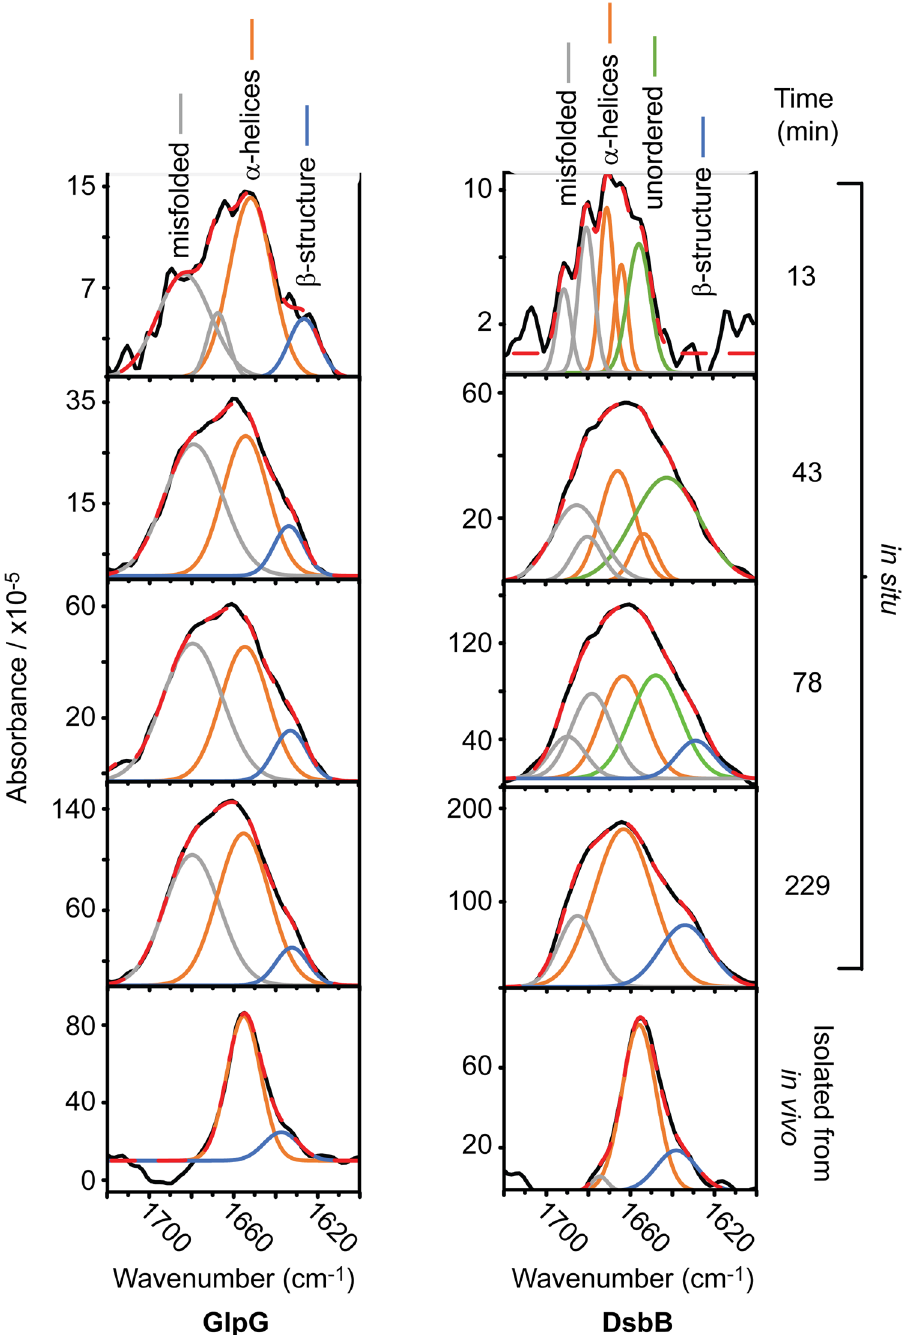
Figure 4. Secondary structure contributions over time during GlpG and DsbB cell-free synthesis. Raw SEIRAS spectra of the amide I band during GlpG (left) and DsbB (right) cell-free synthesis, insertion and folding into DMPC nanodiscs. A change in the proportion of each secondary structure type occurs as folding progresses. The black line is the experimental data and the dashed red line is the cumulative fit of the individual Gaussian contributions. Overall GlpG has lower band intensities in comparison to DsbB; this is likely due to the unfavourable insertion of GlpG into DMPC (Fig. 2). Secondary derivative analysis of the raw FT-IR spectra was used to assist in band position assignment (Fig. S3), with all derived band positions provided in Table